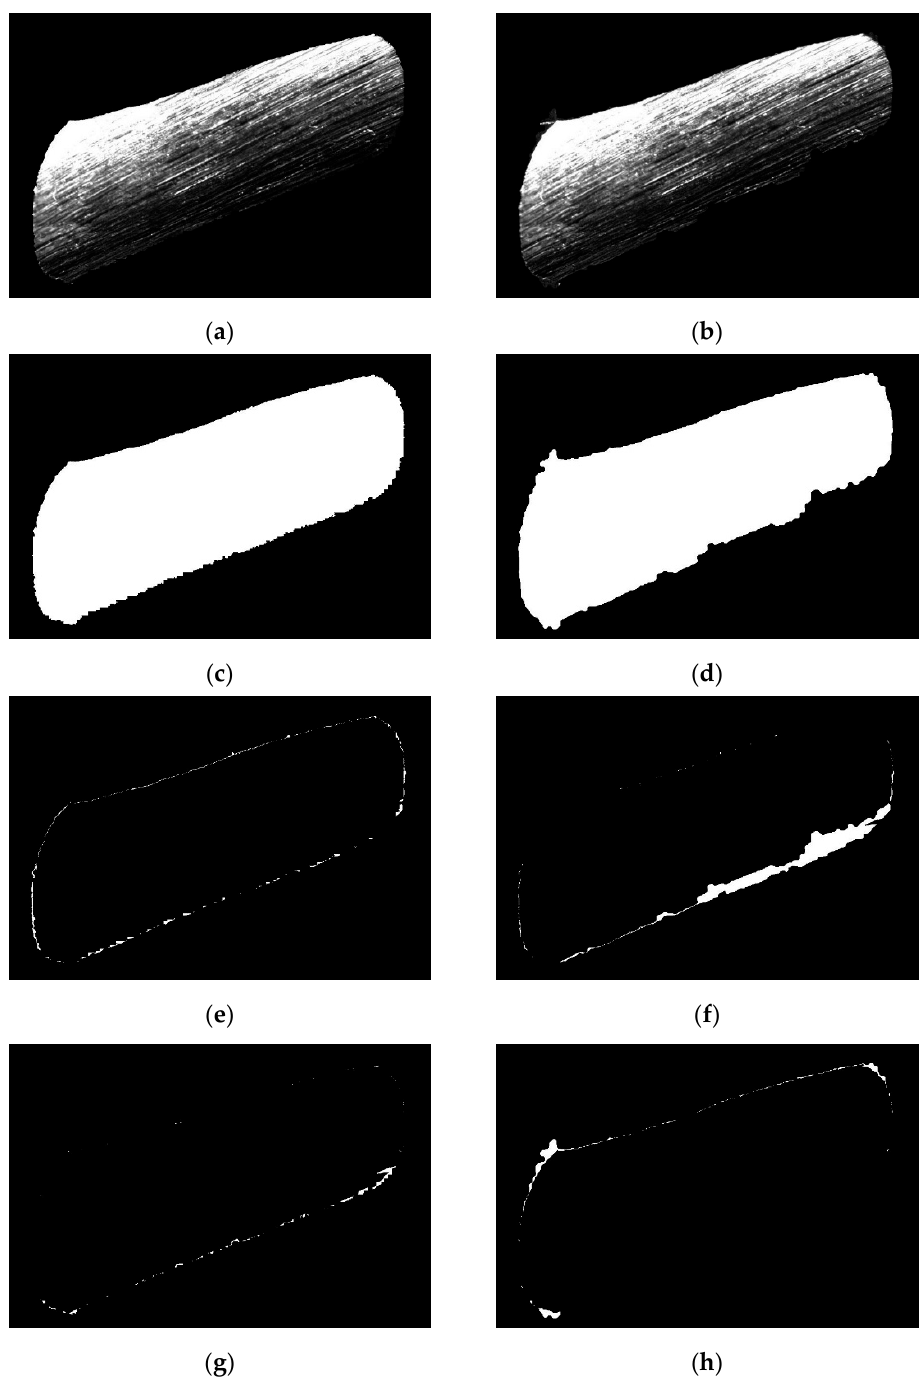
Figure 13. Comparison of segmentation results between the local multi-neural network (Lc-MNN) algorithm and the threshold algorithm: ( a ) Lc-MNN algorithm segmentation result; ( b ) threshold